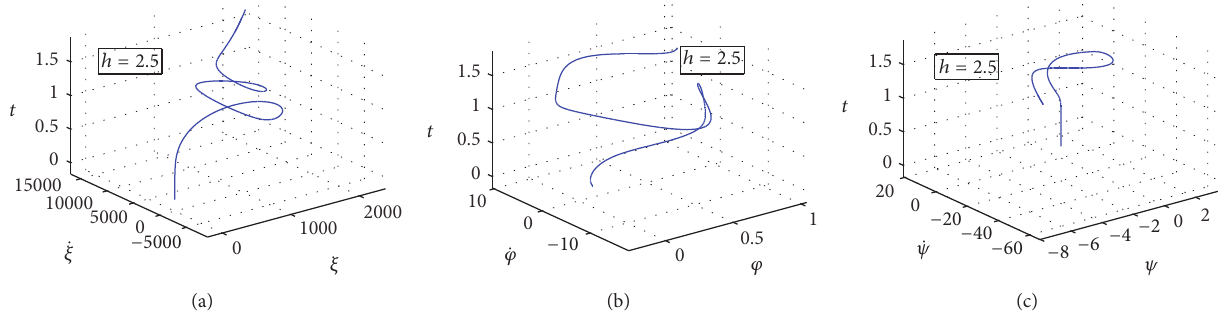
̇𝜉 versus 𝑡 , (b) illustrates the